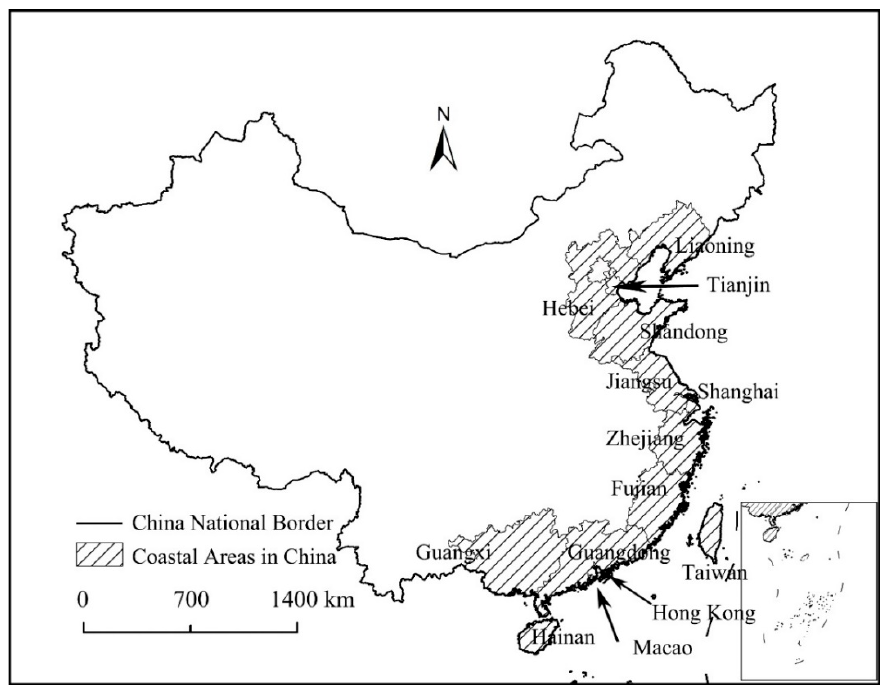
Figure 2. The location of Coastal Areas in China (authors’ own composition).